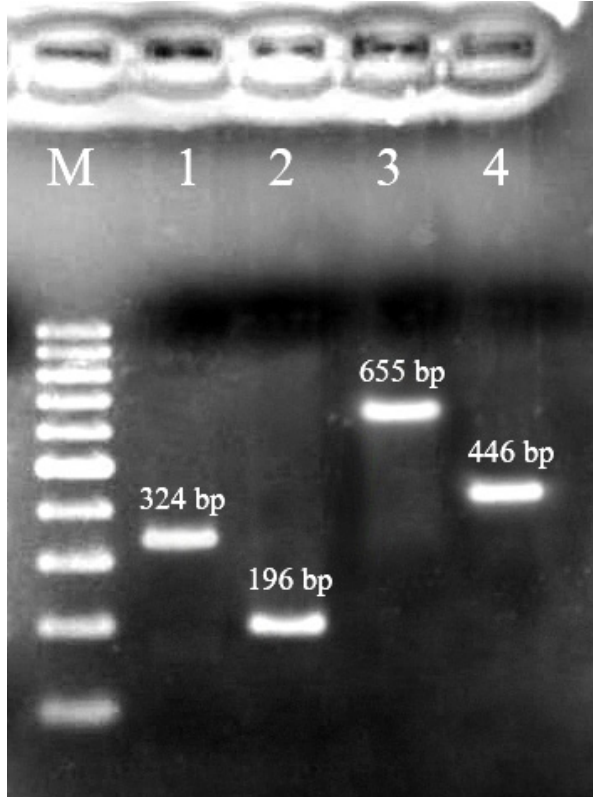
Figure 1. Detection of C. perfringens toxin genes amplified by single PCR. M: marker (DNA ladder, 100 bp); lane 1: a toxin encoding gene; lane 2: β toxin encoding gene; lane 3: ε toxin encoding gene; lane 4: ι toxin encoding gene.